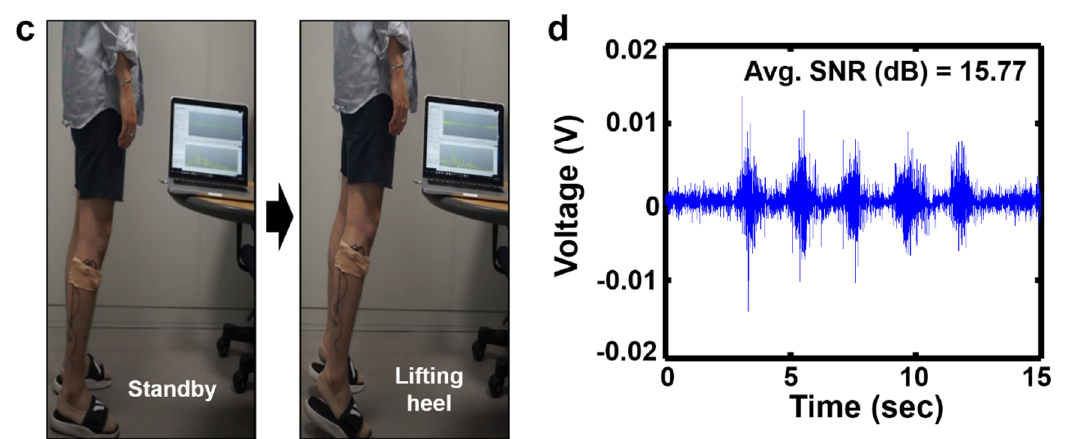
Figure 6. Results of wireless EMG by connecting the epidermal sensors with the wireless module: ( a ) The Schematic illustration of wireless EMG module and monitoring process; ( b ) The Experimental setup of wireless EMG monitoring and photographic images of the wireless EMG module; ( c ) Calf lift motions to activate EMG of soleus; ( d ) Activated EMG signals of soleus acquired by wireless epidermal sensing system in calf lift motions.